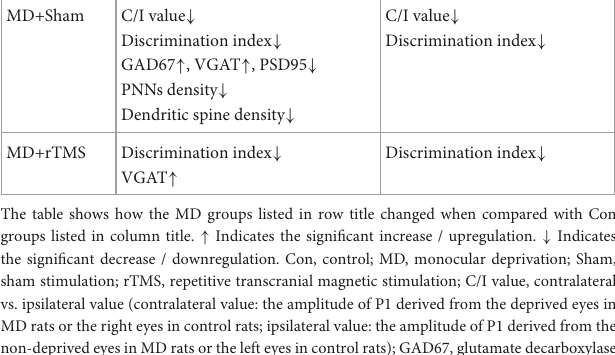
TABLE 1 Results comparison between control (Con) groups and monocular deprivation (MD) groups. Con+Sham